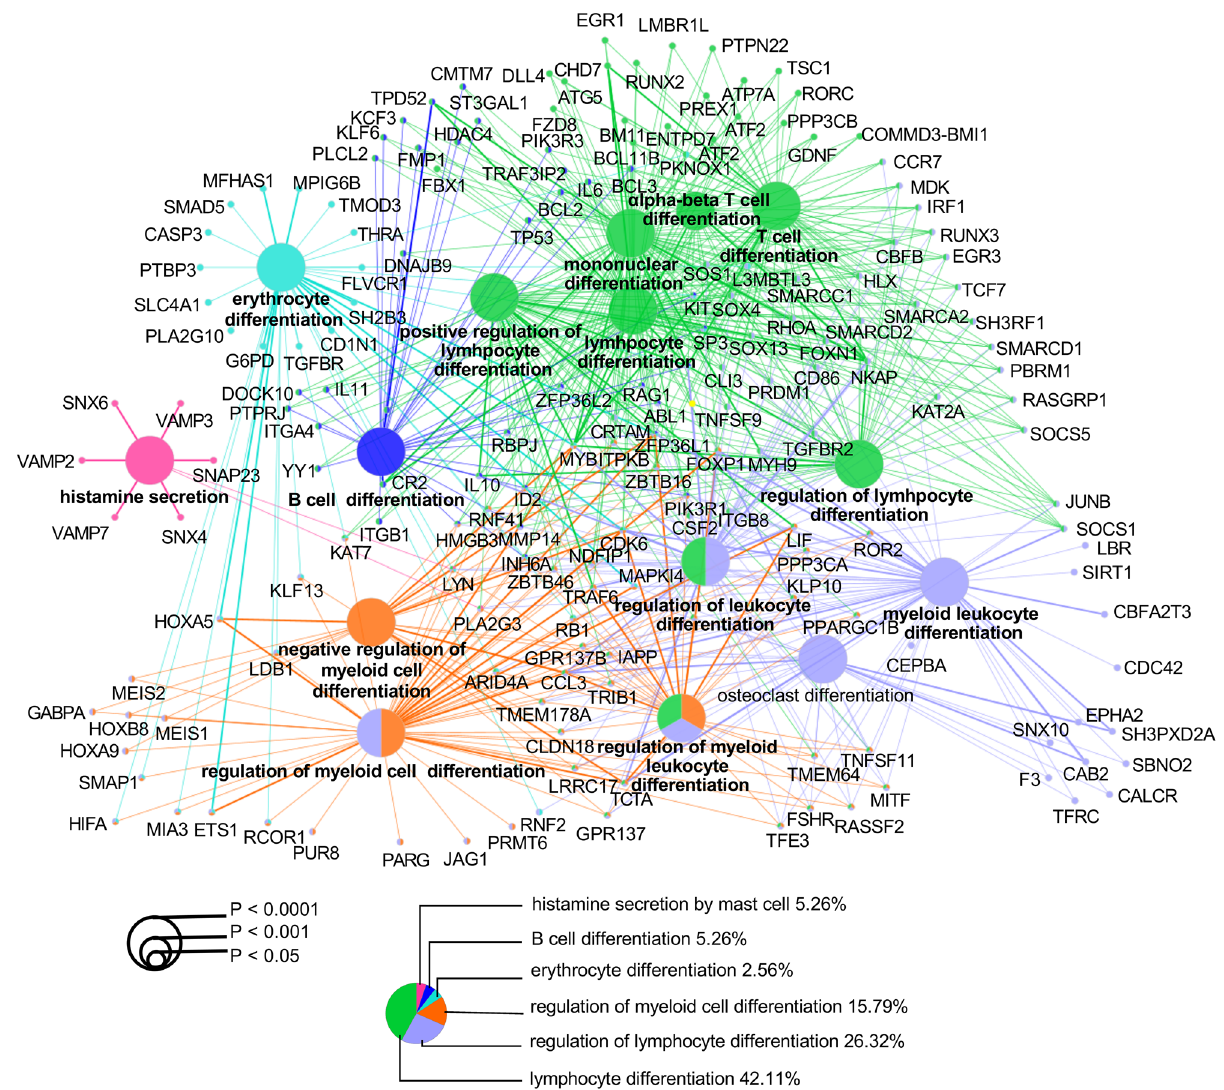
Figure 6. Functional enrichment of the miR